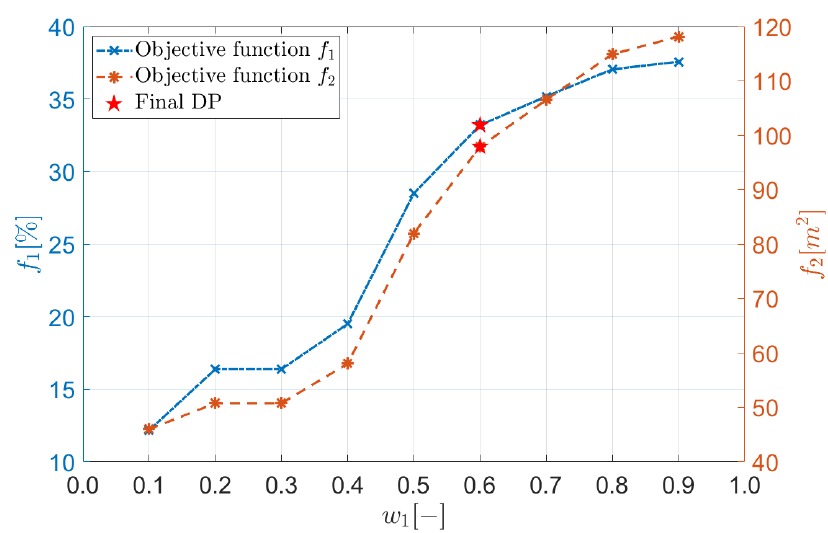
Figure 7. Values of the objective functions for selected weight distributions.